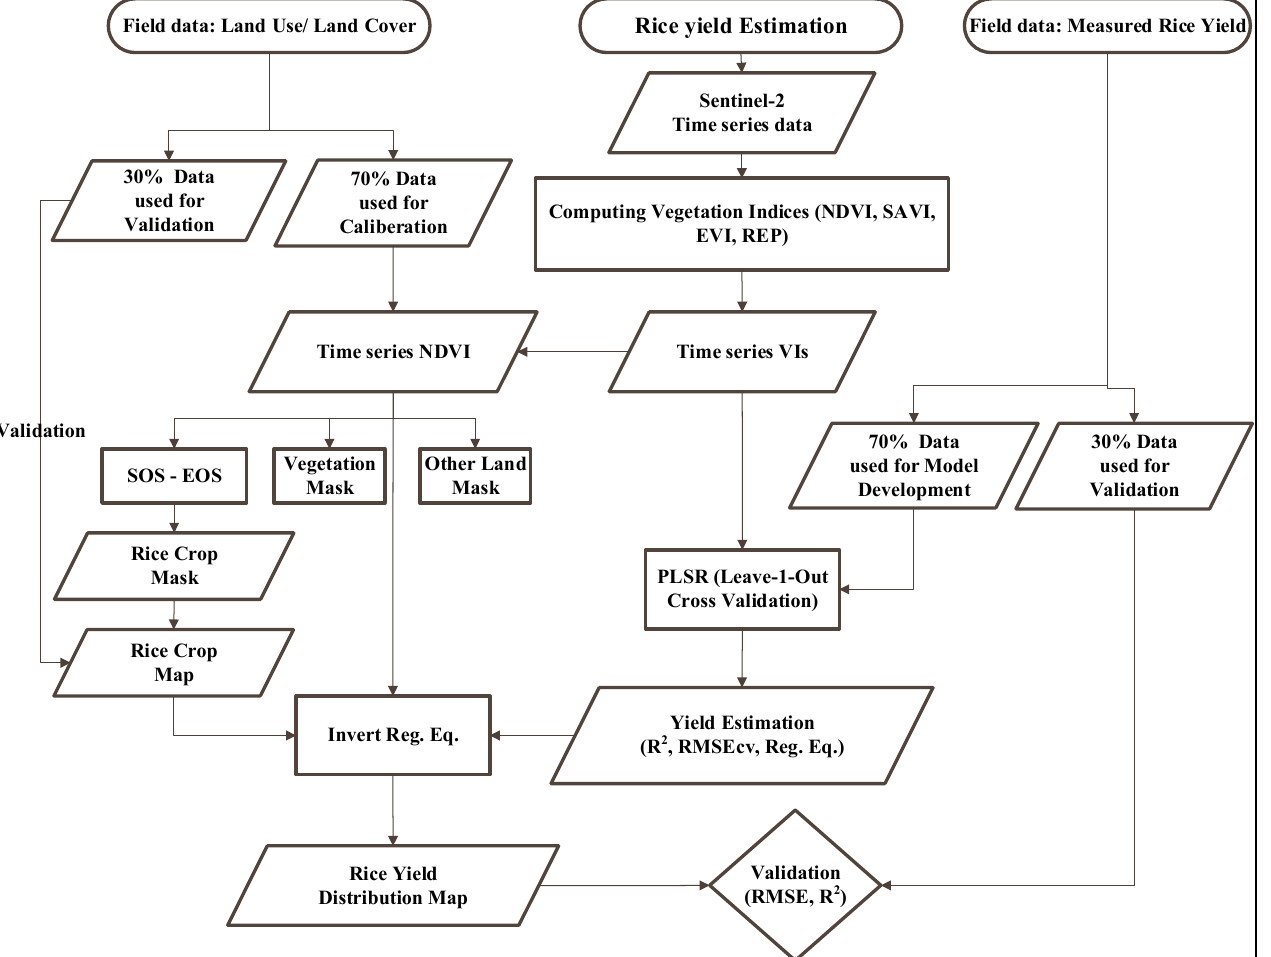
Figure 4. The framework of methodology followed for phenology-based rice mapping and yield estimation. To develop the spatial distribution maps of rice yield, the models of statistical analysis (the regression equations of PLSR analysis) were inverted to the time series vegetation indices of rice masked areas (developed from phenological based mapping) and were validated with an independent